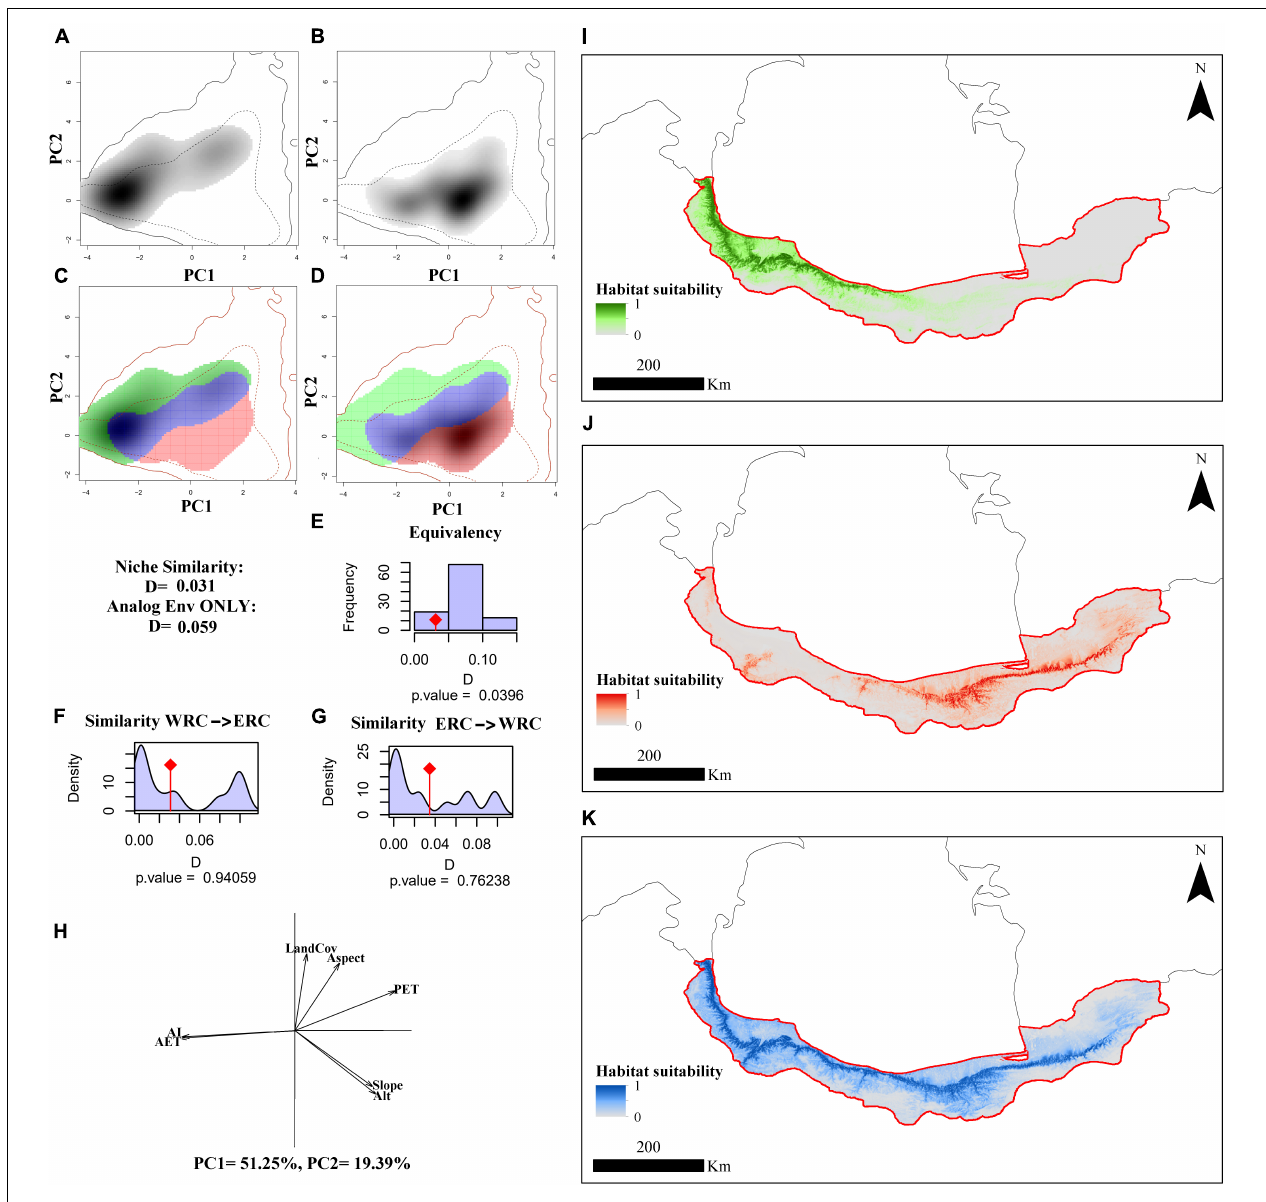
FIGURE 3 | The macro-environmental niche of the Hyrcanian wood frog, Rana pseudodalmatina across Hyrcanian forests, Iran. Panels (A,B) illustrate the species’ niche in the western and eastern distribution ranges, respectively, along the two first axes of the PCA. The density of the species’ occurrences in the cell is shown in the gray shade. The solid and dashed contour lines represent 100 and 50% of the available (background) environment, respectively. Panels (C,D) represent the niche overlap values for western (WRC) and eastern regional clades (ERC), respectively. Histograms (E–G) show the observed niche overlap D between the two ranges (bars with a diamond) and simulated niche overlaps (gray bars) on which tests of niche equivalency (E) , niche similarity of WRC to ERC (F) , and niche similarity of ERC to WRC (A) . (H) The contribution of the macro-environmental variables on the two axes of the PCA env and the percentage of inertia explained by the two axes. Potentially suitable areas are based on macro-environmental variables according to WRC (I) , ERC (J) , and species-level (K)